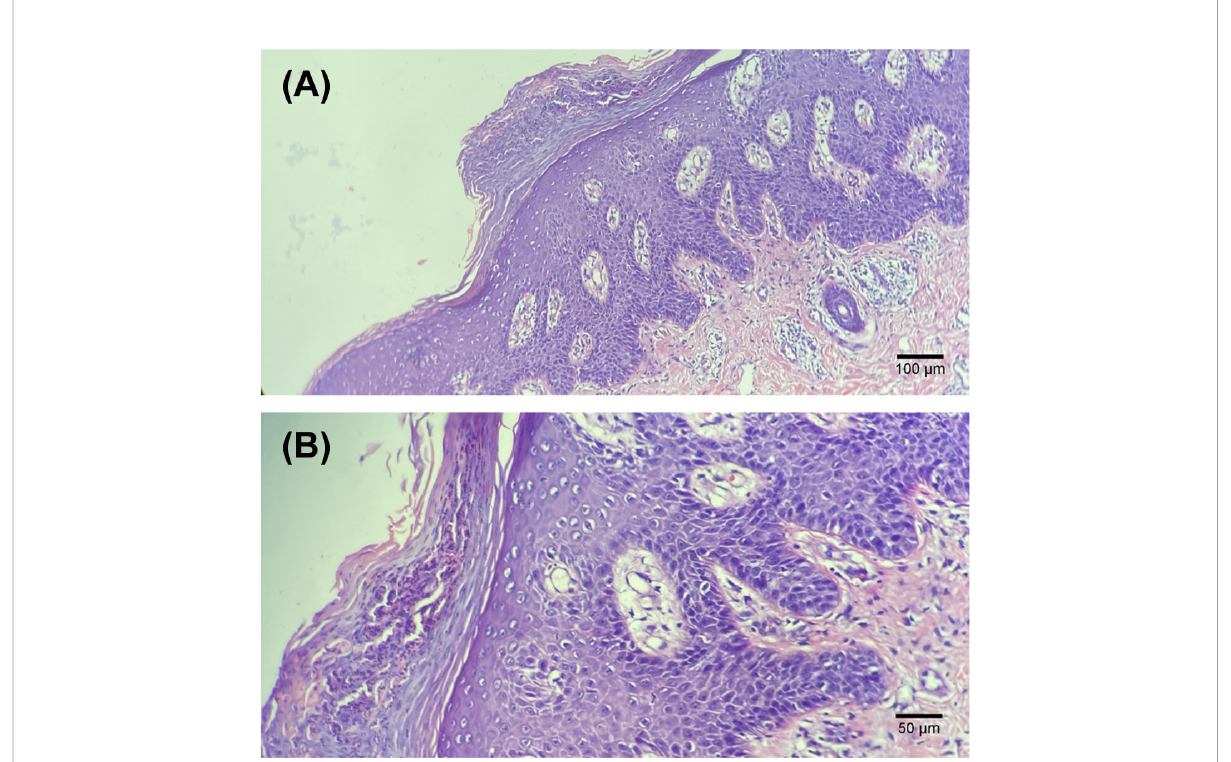
FIGURE 2 Histological examination of the skin biopsy showing typical features of psoriasis, i.e. thickened epidermis with hyperkeratosis and regular acanthosis, neutrophils trapped in the stratum corneum (Munro micro-abscesses), considerable oedema of the dermis and slight lymphocyte in fi ltrate around dermal capillaries. Hematoxylin and eosin staining; ( A , 100× images), ( B ,